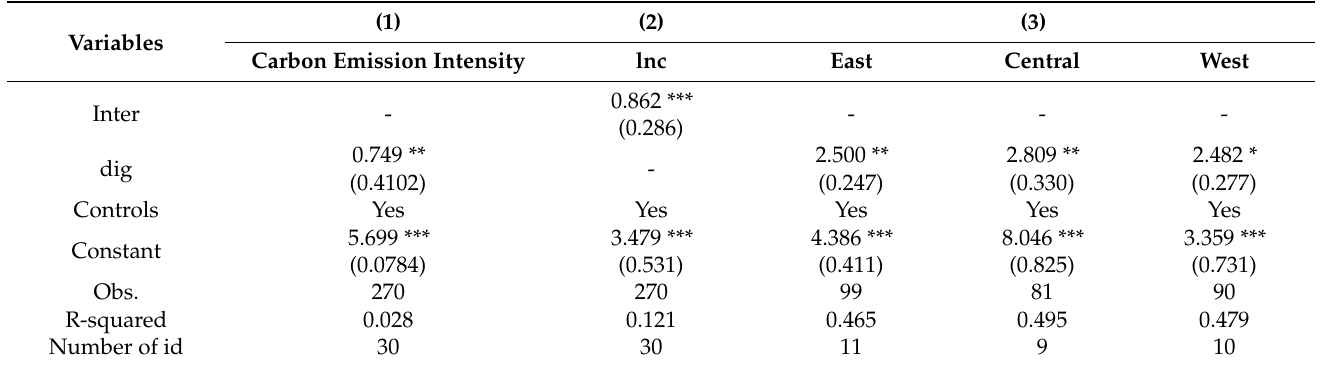
Table 10. Robustness tests of the level of digital innovation affecting carbon emissions in the trans- portation sector.